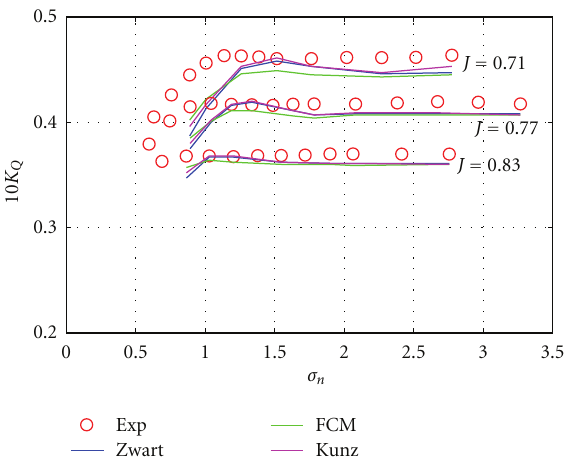
Figure 13: Influence of the cavitation number on the thrust coe ffi cient for the E779A propeller.